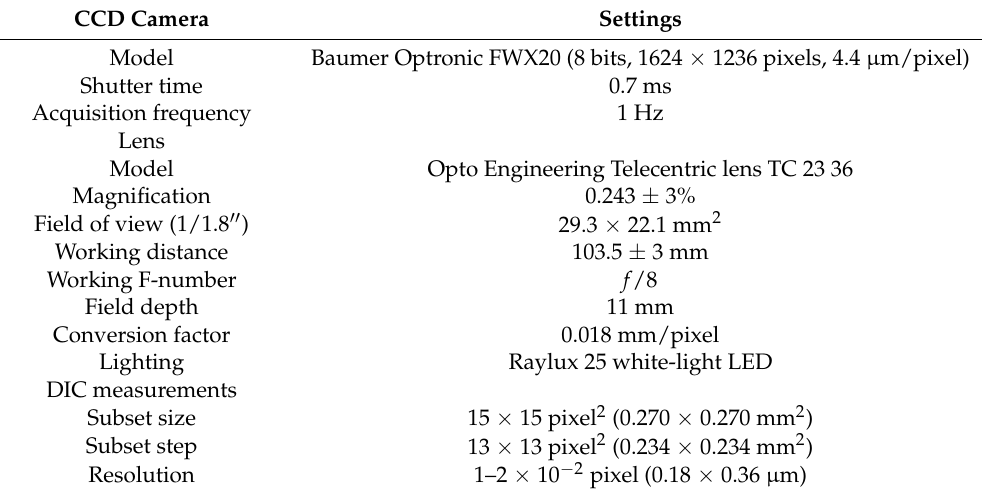
Figure 2. DCB test set-up coupled with digital image correlation (DIC). Table 2. Components of the optical system and DIC measuring